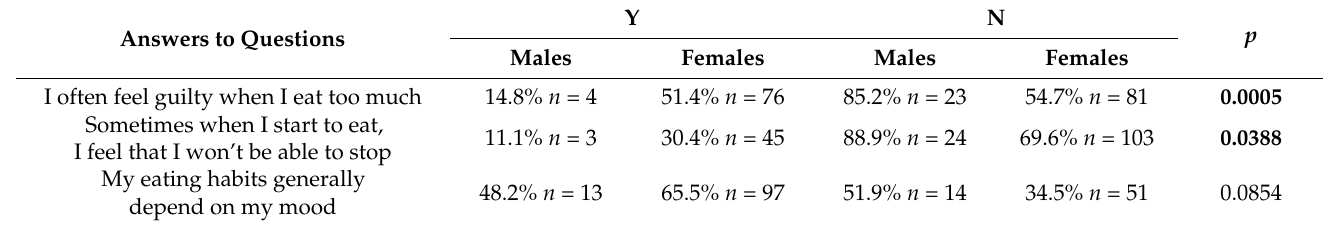
Table 7. The differences in the emotional overeating habits between males and